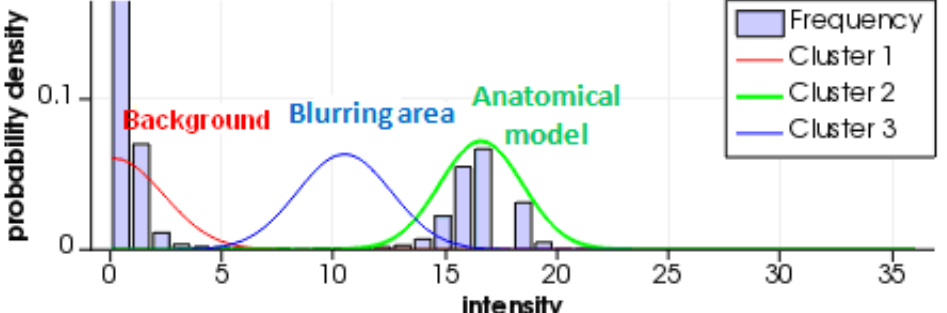
Figure 3. The process of grouping data for the Precimid 1170 material.